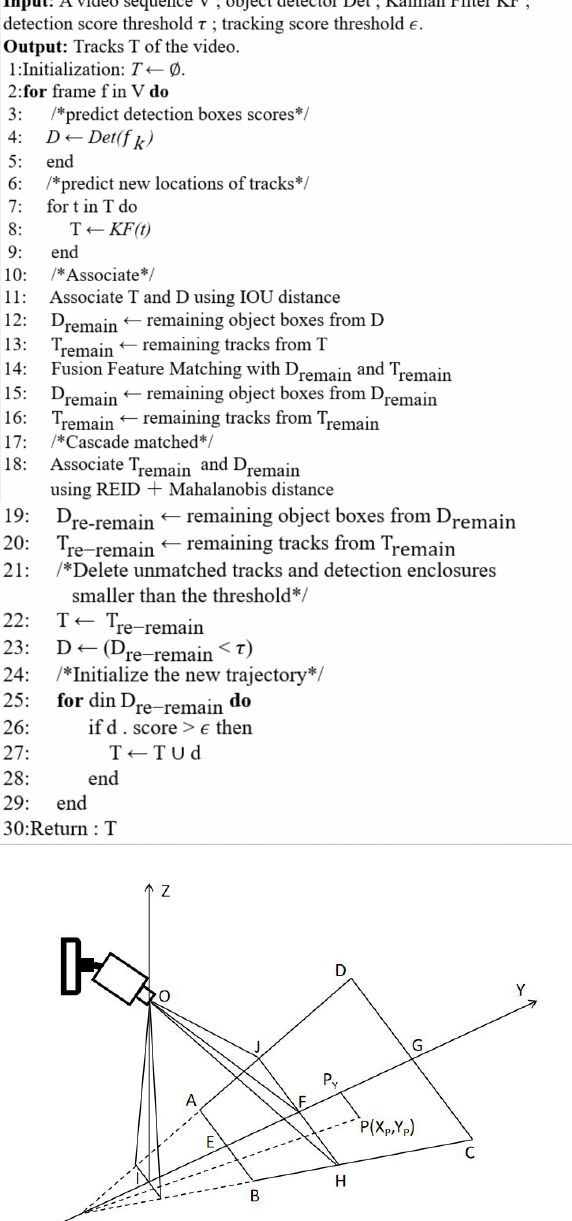
Figure 6 . The geometric relationship of the camera field in the world coordinate system.